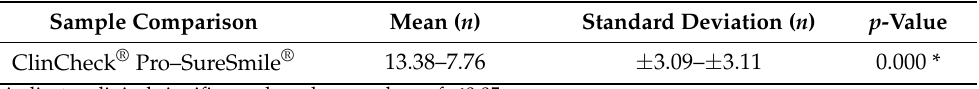
Table 6. Kruskal–Wallis one-way analysis of variance for the number of